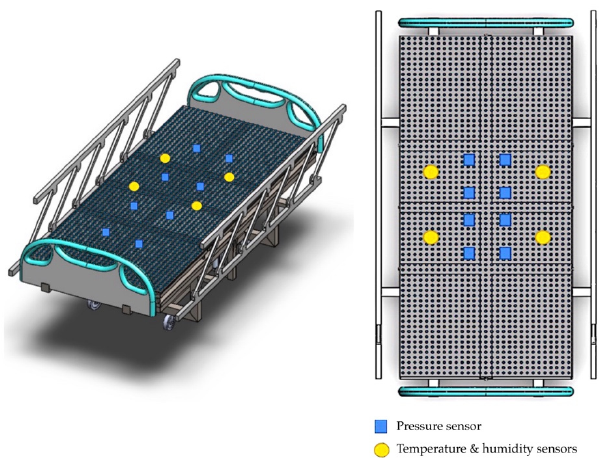
Figure 4. Development of the mattress.